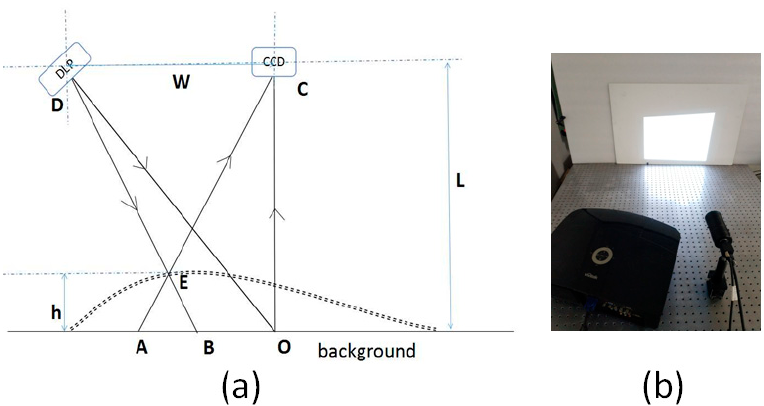
Figure 6. Fringe projection experiment: ( a ) Schematic layout; ( b ) physical diagram. The optical path adopted oblique projection and vertical shooting. The digital fringe projector chosen was Vivitek-D5158HD at a resolution of 1920 × 1280 pixels. The camera used was the Basler ace 1600-20 g, with a resolution of 1600 × 1200 pixels. The optical axis of the projection and the receiving end intersected at point O. Moreover, the camera and the digital fringe projector were at the same height L. Due to modulation by the object’s height, light that was supposed to obtain at point B was cast on point E, but the light point recorded by the camera was A. Finally, the height information of the object was recorded in the fringe pattern. A 1-mm-thick disk was chosen as the measurement object. The position and angle of the disk were altered to obtain different fringe patterns. To obtain a sufficient number of images to meet the big data requirement of network training, such data extension as image cropping, translation, and rotation were used. One thousand fringe patterns were obtained. Figure 7 shows one of these and its corresponding phase-shifting fringe